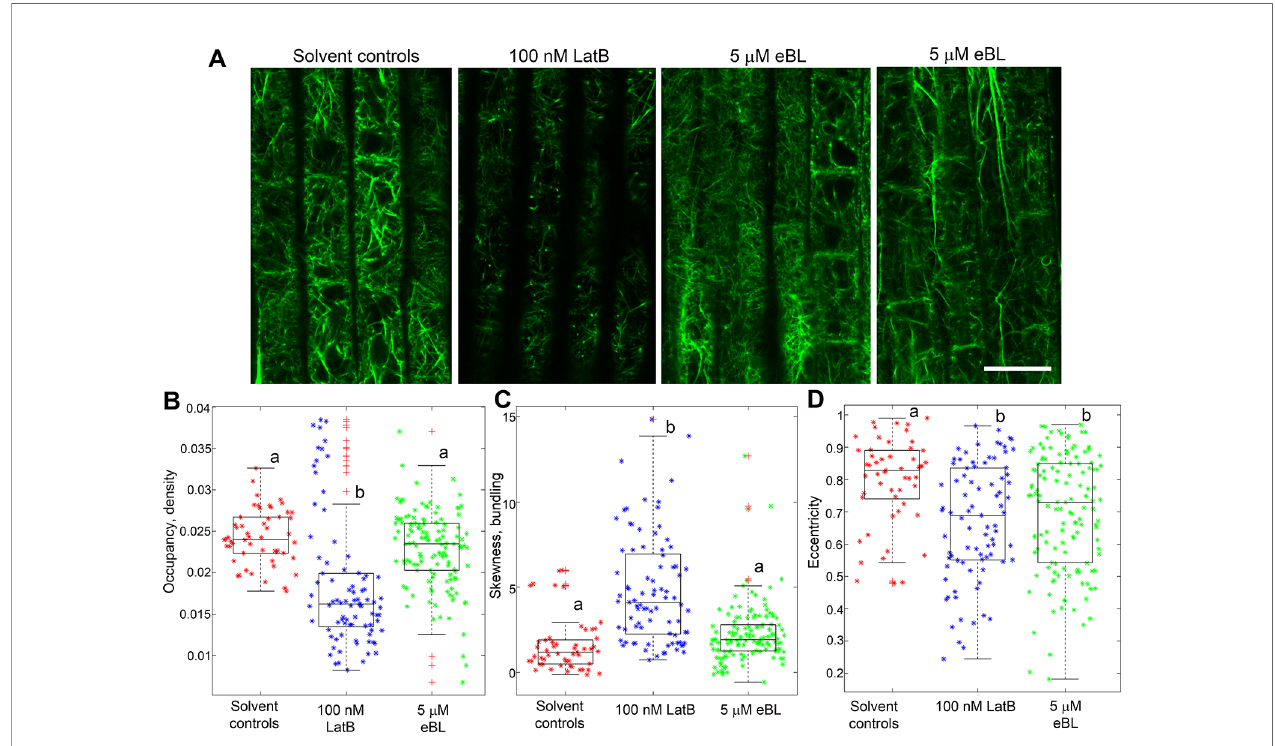
FIGURE 5 | F-actin organization in epidermal cells of living M. truncatula roots expressing UBQ10:GFP-ABD2-GFP after 1 h exposure to LatB or eBL. (A) Representative single confocal optical section images of cells in the elongation zone. Note the reduced fl uorescence and extensive fragmentation of F-actin in cells treated with LatB but not with eBL. The two right most panels show variable effects of eBL on F-actin organization. (B – D) Combined box and scatter plots showing quantitative analysis of F-actin occupancy (density), skewness (bundling) and eccentricity in root cells of the transition/elongation zone. Unlike LatB-treatment, no signi fi cant differences between eBL and solvent controls were detected with regard to F-actin occupancy (B) and skewness (C) . However, a signi fi cant difference was observed between eBL and solvent controls with regard to the eccentricity metric, which refers to alignment of F-actin (D) . Asterisks (*) refers to individual data points and + mark outliers. Statistical signi fi cance was determined by one-way ANOVA. Bars are means (n > 50 cells) ± S.E. Different letters indicate signi fi cant differences among means (P < 0.05, Tukey ’ s test). Scale bar = 20 m